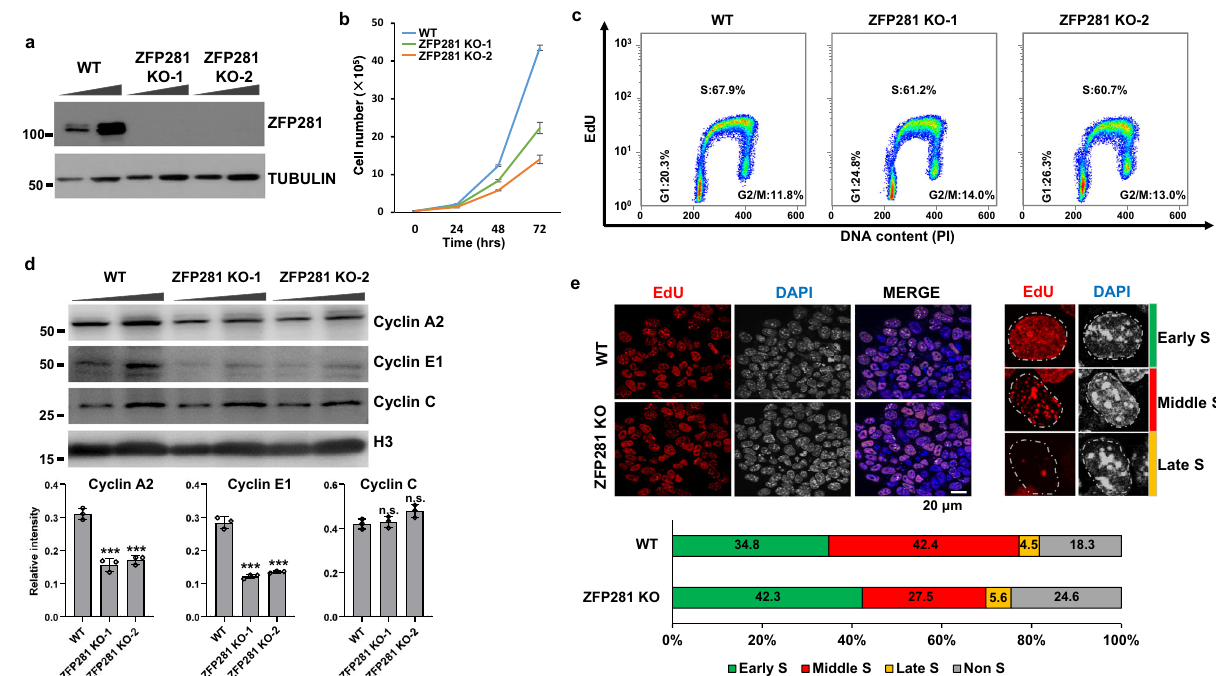
Fig. 1 ZFP281 is required for proper S phase progression in mouse ES cells. a Western blot showing successful depletion of ZFP281 in mouse ES cells by CRISPR-Cas9. α -TUBULIN was used as a loading control. Four independent experiments show similar results. b Growth curve showing numbers of WT (yellow), ZFP281 KO-1 (green), and ZFP281 KO-2 (red) mouse ES cells counted at different time intervals after plating. Mean ± SEM from three independent experiments. c Flow cytometry analysis showing the percentage of WT, ZFP281 KO-1, and ZFP281 KO-2 ES cell at different cell cycle phases. Three independent experiments show similar results. d Western blot analysis (upper panel) showing the levels of Cyclin A2, Cyclin E1 and Cyclin C in WT, ZFP281 KO-1, and ZFP281 KO-2 ES cells. Histone H3 was used as a loading control. Gray values (lower panel) of Cyclin A2, Cyclin E1 and Cyclin C protein bands were determined by Image J and normalized to the loading control. Mean ± SEM from three independent experiments. Two-tailed, unpaired Student ’ s t tests were performed. (Cyclin A2, WT vs. ZFP281 KO-1, p = 0.0005; WT vs. ZFP281 KO-2, p = 0.0003. Cyclin E1, WT vs. ZFP281 KO-1, p = 0.0001; WT vs. ZFP281 KO-2, p = 0.0001. Cyclin C, WT vs. ZFP281 KO-1, p = 0.6566; WT vs. ZFP281 KO-2, p = 0.0500.) ∗ p < 0.05, ∗∗ p < 0.01, ∗∗∗ p < 0.001, n.s. = not signi fi cant. e EdU staining pattern (upper left) of WT and ZFP281 KO ES cells, DNA was counterstained using DAPI; Representative images showing the EdU staining pattern (upper right) of mouse ES cells at early, middle and late S phase; Percentage of WT (total n = 422) and ZFP281 KO ES (total n = 338) cells at different stages of S phase. Three independent experiments show similar results. Source data are provided as a Source Data fi